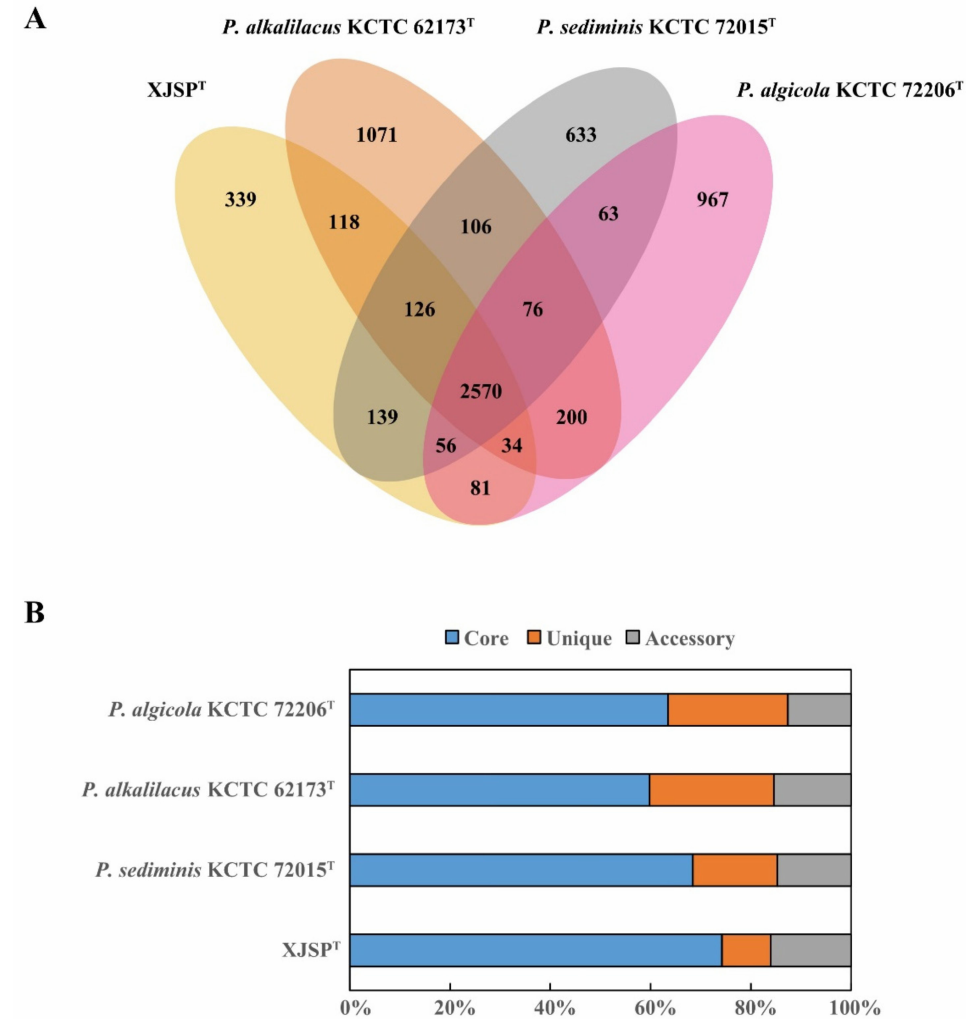
Figure 3. Comparisons of Pseudotabrizicola orthologous protein groups in four Pseudotabrizicola genomes. ( A ) Venn diagram displaying the numbers of core gene families and unique genes for each of the four Pseudotabrizicola strains. ( B ) Percentage of core, accessory, and unique genes in each of the four